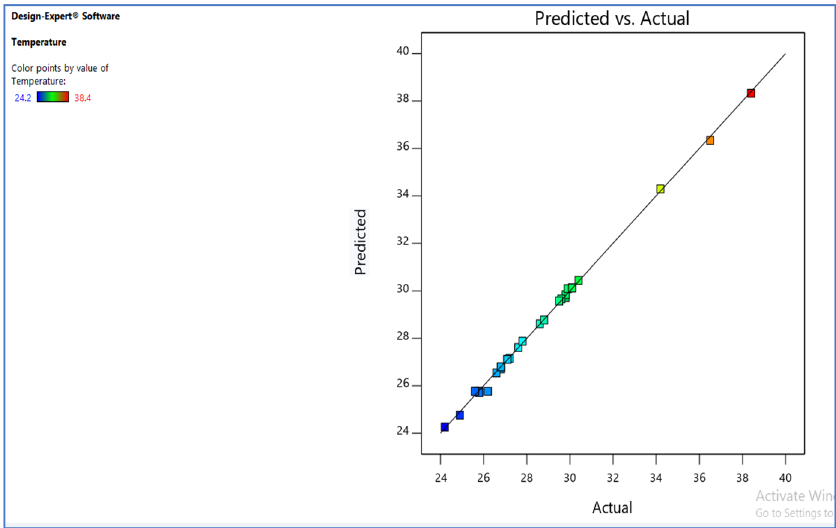
Figure 5. Predicted vs. actual.